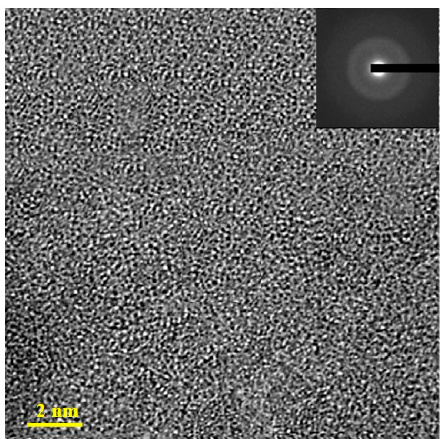
Figure 6. ∆ H i / ∆ H 0 for the BMG matrix and welds processed with different currents.